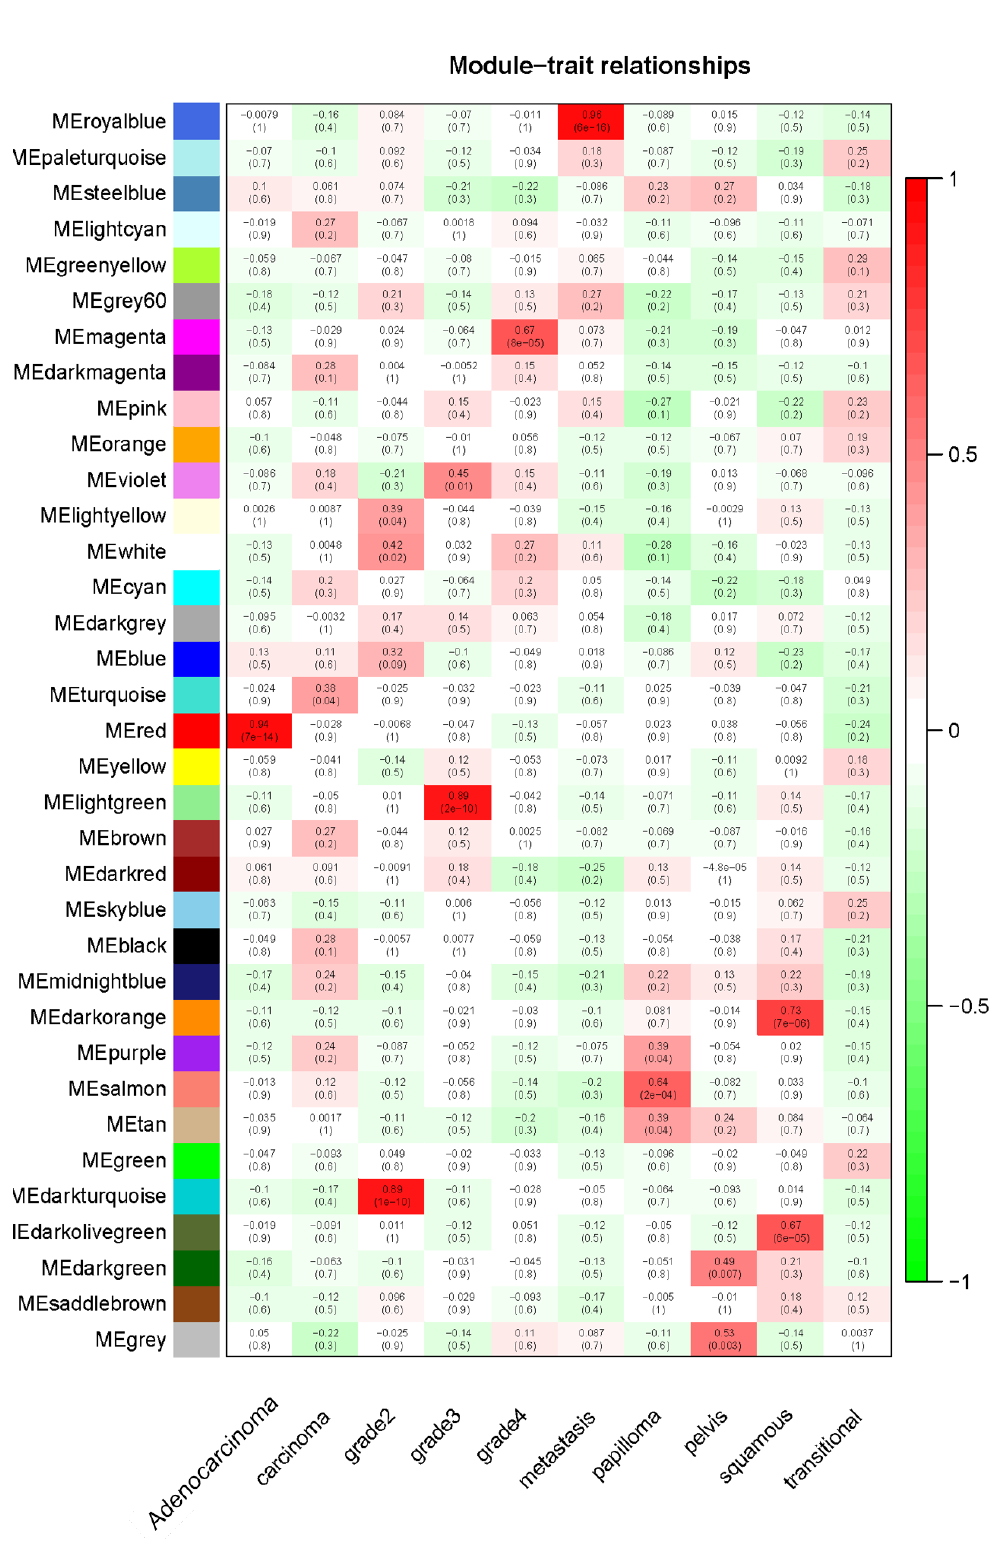
Figure 4. Heatmap of the correlation between module eigengenes and clinical subtypes of bladder cancer. Each column contained the corresponding correlation and p value.